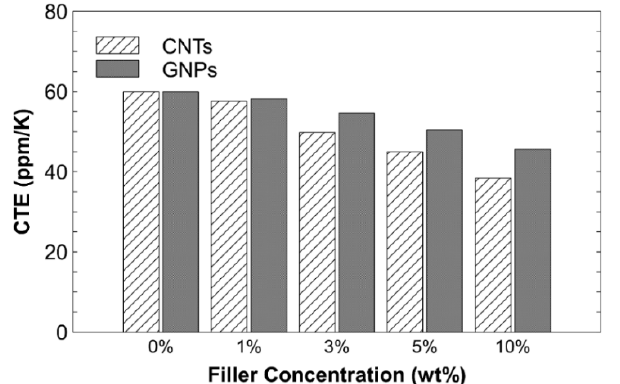
Figure 7. Effect of adding CNTs and GNPs on the coefficient of thermal expansion of the resultant composites.